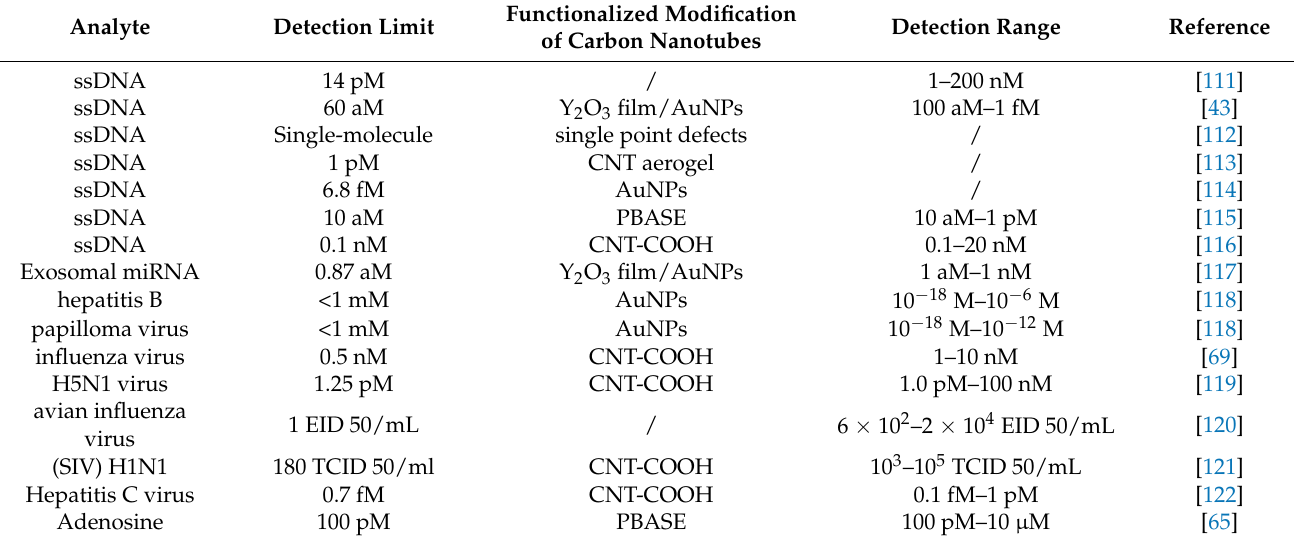
Table 1. DNA detection based on